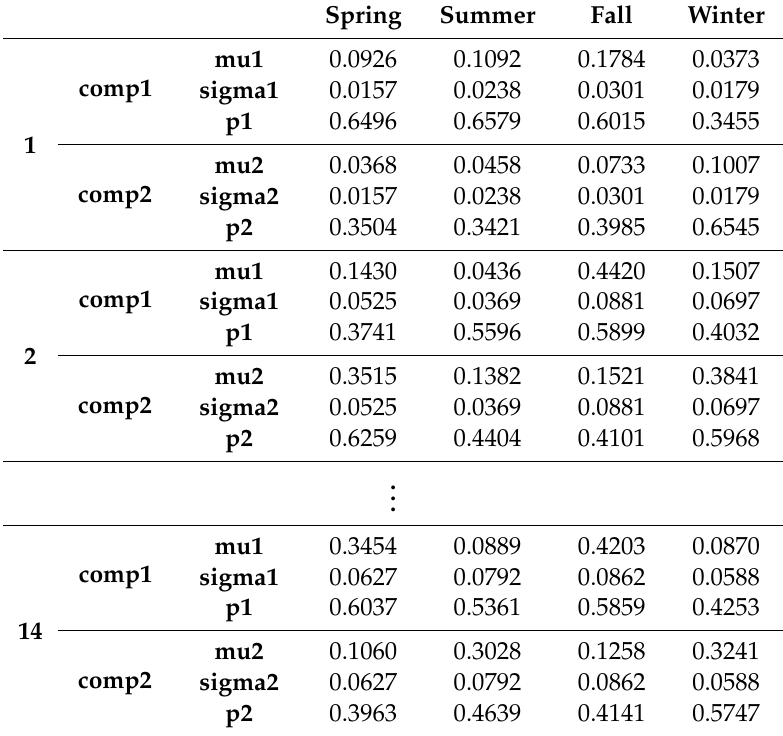
Table 5. The Gaussian mixture distribution parameters of EV charging demand in Jeju Island.